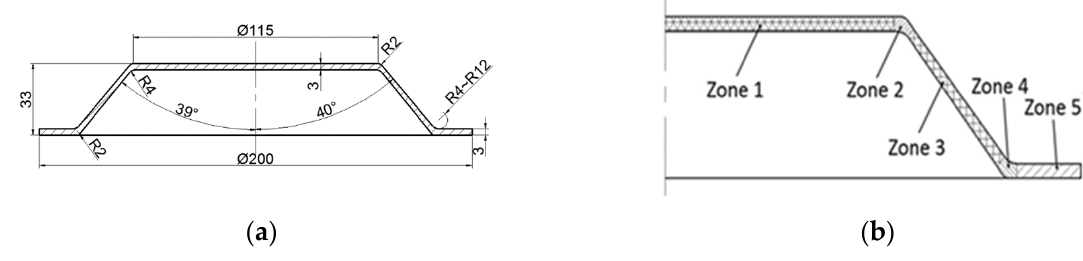
Figure 1. Structure of target part: ( a ) Part sectional drawing; ( b ) Part partition.